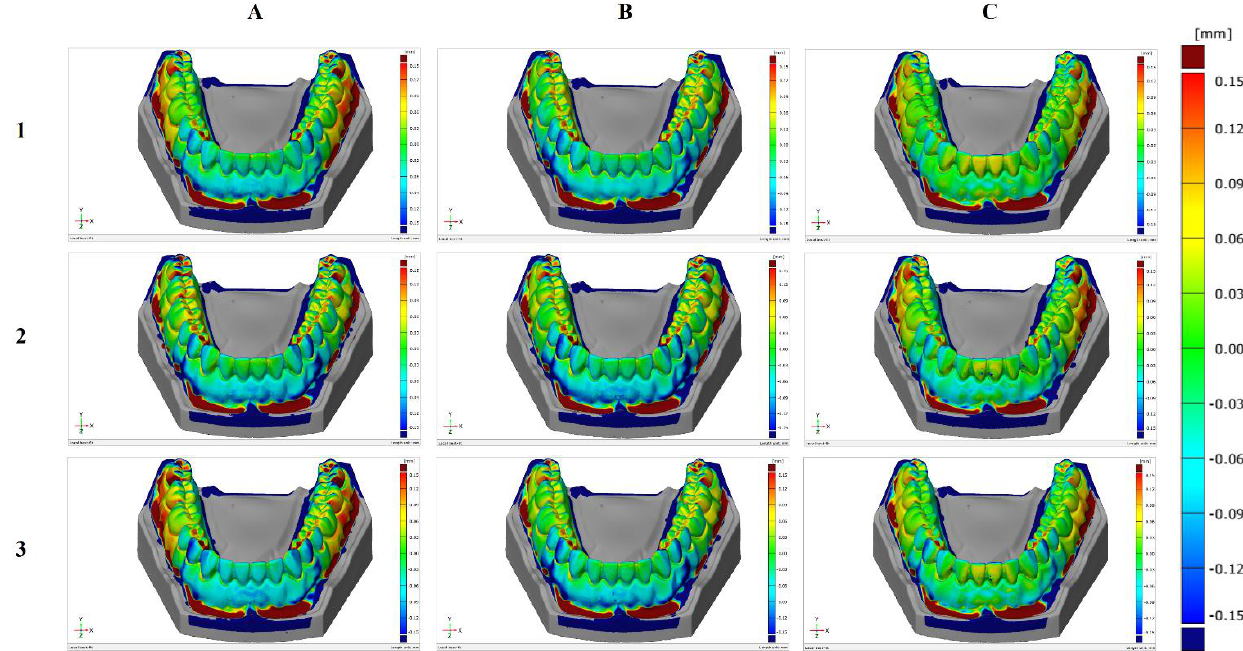
Figure 3. Surface comparison of the three printed models with the reference model for each material: ( A ) Producer 1; ( B ) Producer 2; ( C ) Producer 3.